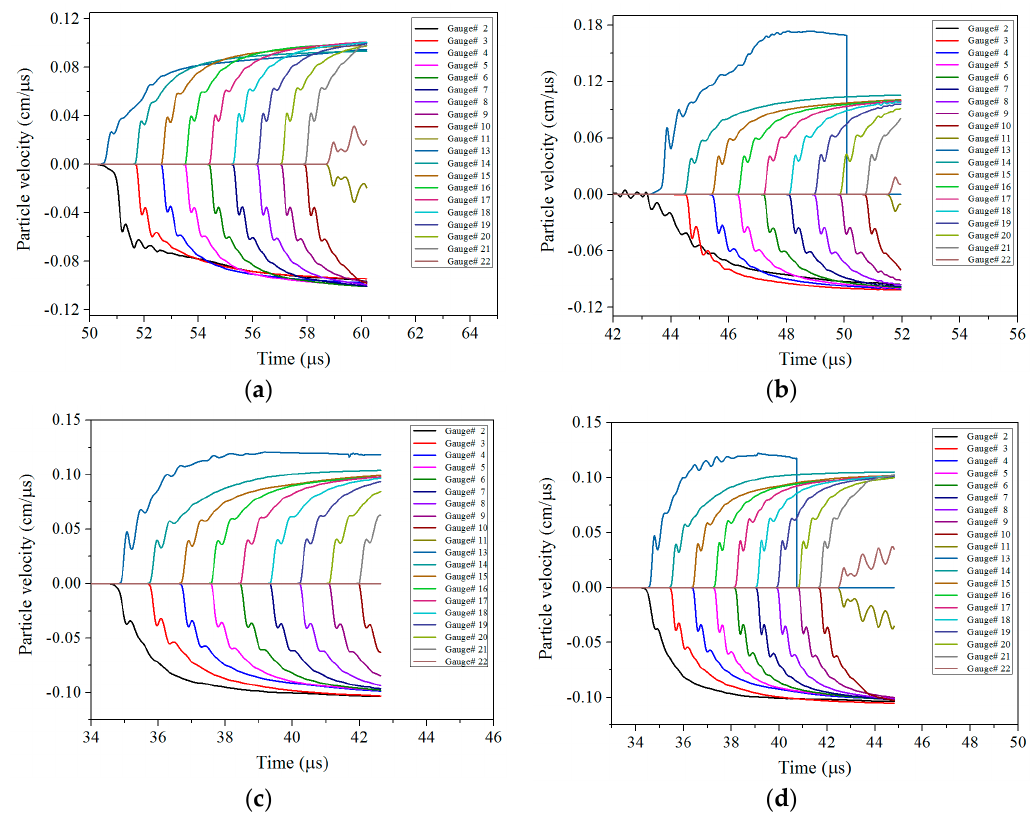
Figure 11. The particle velocity of the Gauss points in the front and rear panels for different liners: ( a ) Copper; ( b ) Floatglass; ( c ) Lucite; and ( d ) Plexiglas.